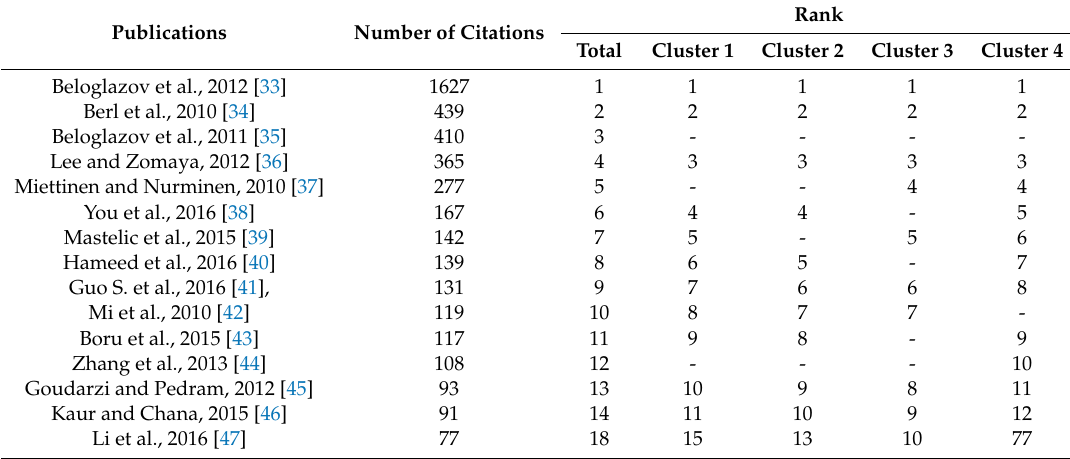
Table 7. Core references in the thematic clusters in research on cloud computing energy e ffi